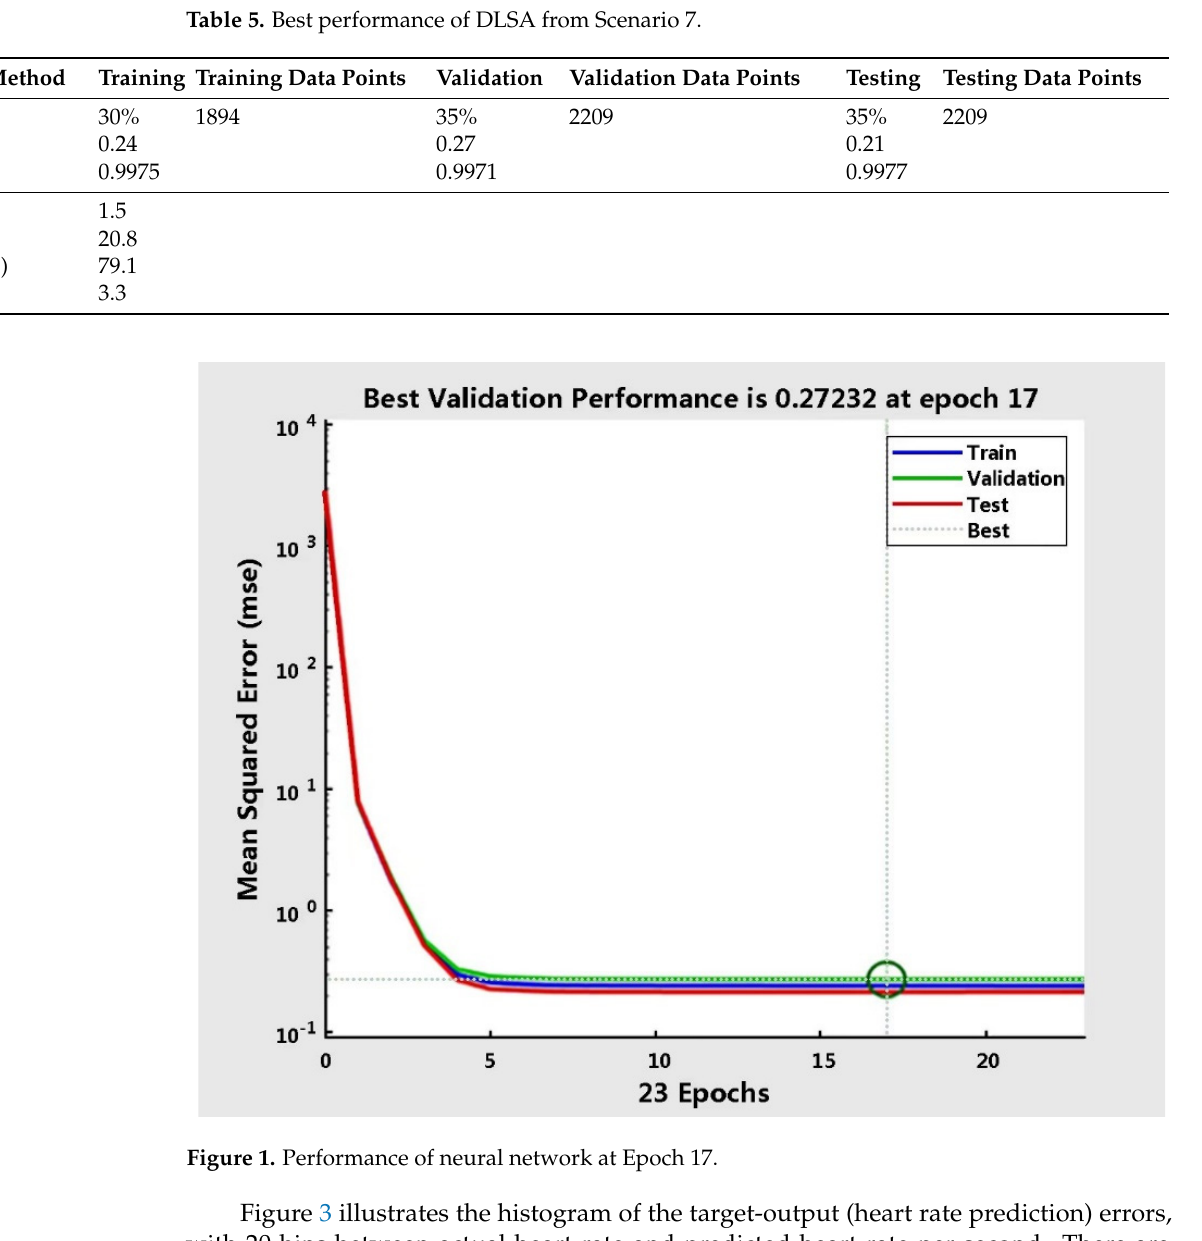
Table 5. Best performance of DLSA from Scenario 7.